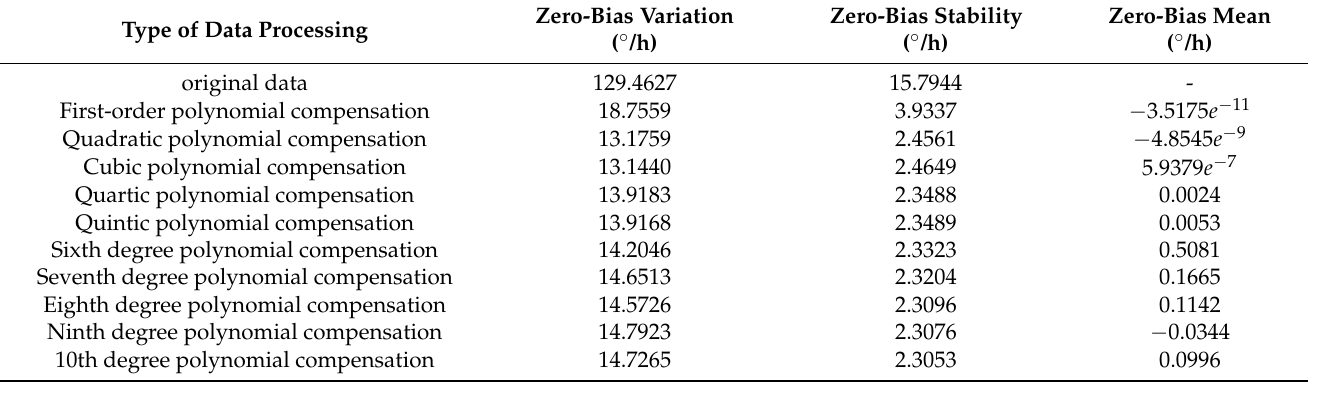
Table 1. Comparison of fitting effects of different polynomial degrees.